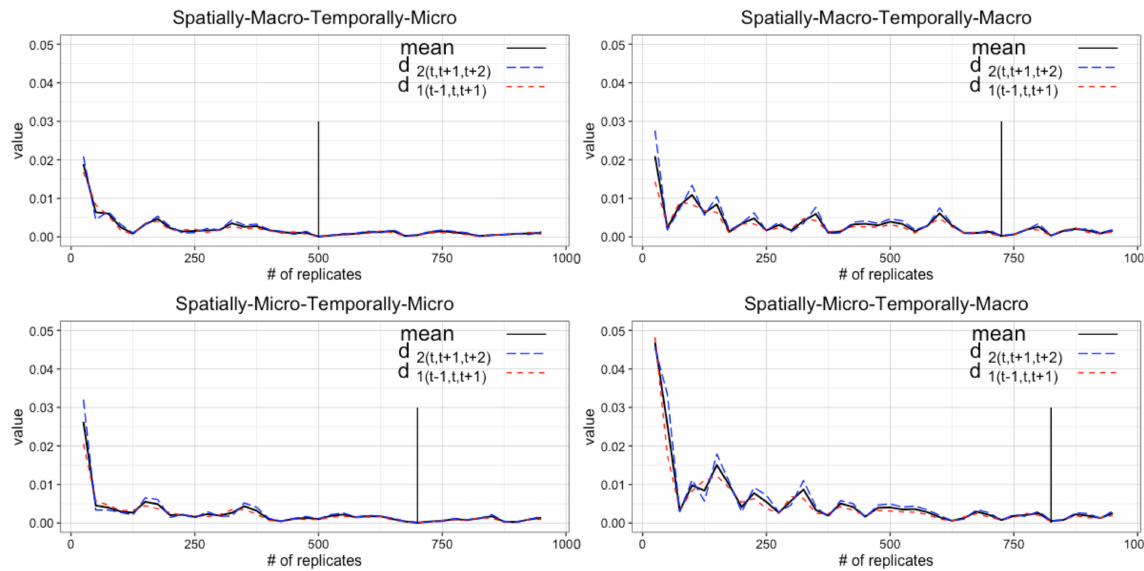
Figure 8. Changes of d 1 ( p , t ) and d 2 ( p , t ) over the number of replicates.